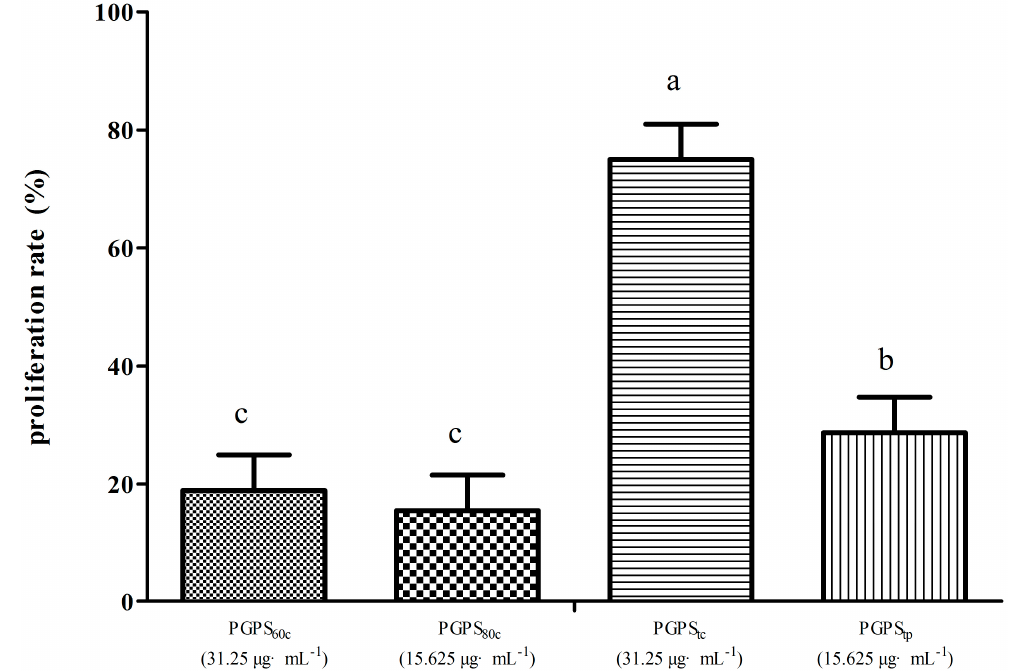
Figure 2. The highest lymphocyte proliferation rates of each group in synergistically stimulation of PGPSs with PHA. The values are presented as means ± SE ( n = 4). a–c Bars without the same superscripts differ significantly ( p < 0.05). Table 3. Changes in OD 570 value of peripheral blood lymphocyte proliferation of each group in synergistically stimulation of PGPSs with phytohemagglutinin (PHA) (OD 570 value) ( n = 4). Concentration ( μ g · mL − 1 )